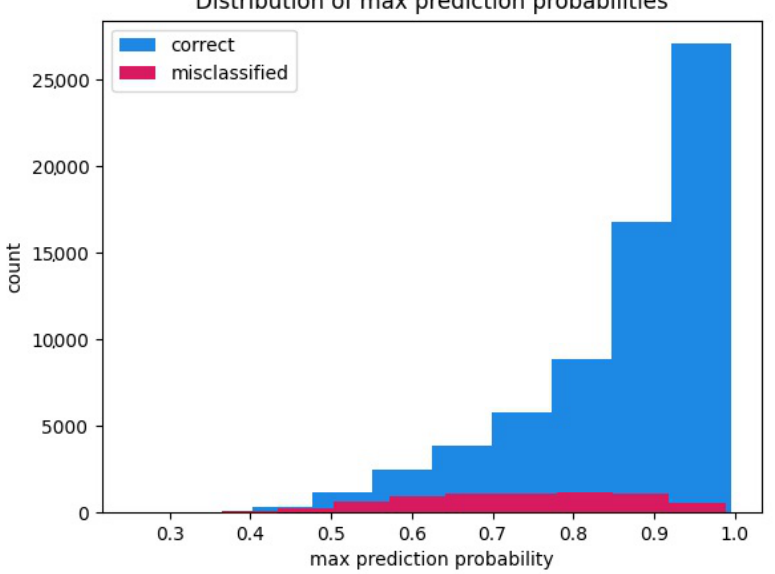
Figure 7. Distribution of maximum prediction probabilities for both correct and misclassified in- stances. Higher values show that our model predicts the instance class with higher confidence. We observe that the largest part of the correctly classified instances, were predicted with high